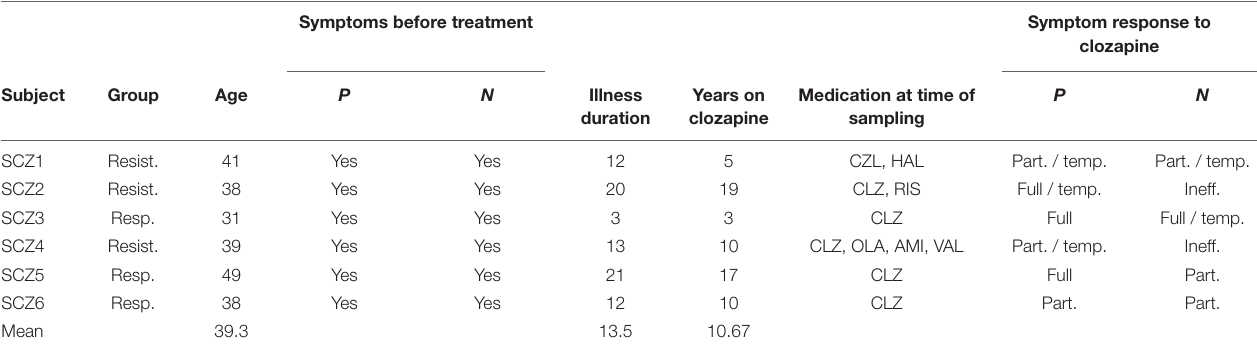
TABLE 1 | Clinical characteristics of the samples. Symptoms before